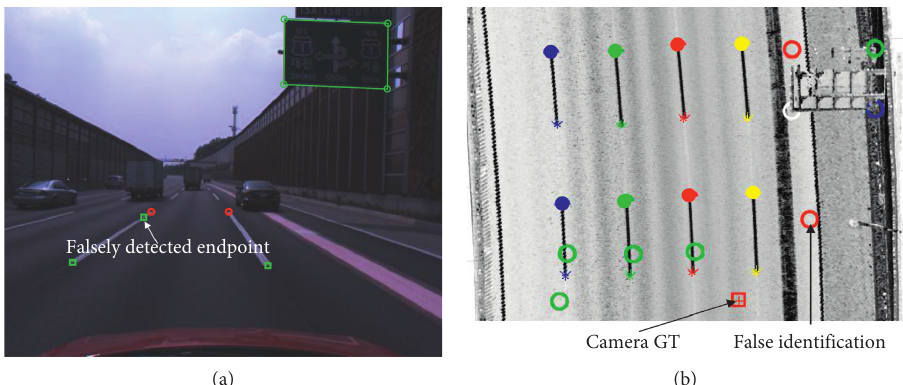
Figure 17: Ego-lane identification failure by a falsely detected lane endpoint: (a) falsely detected lane endpoint; (b) localization